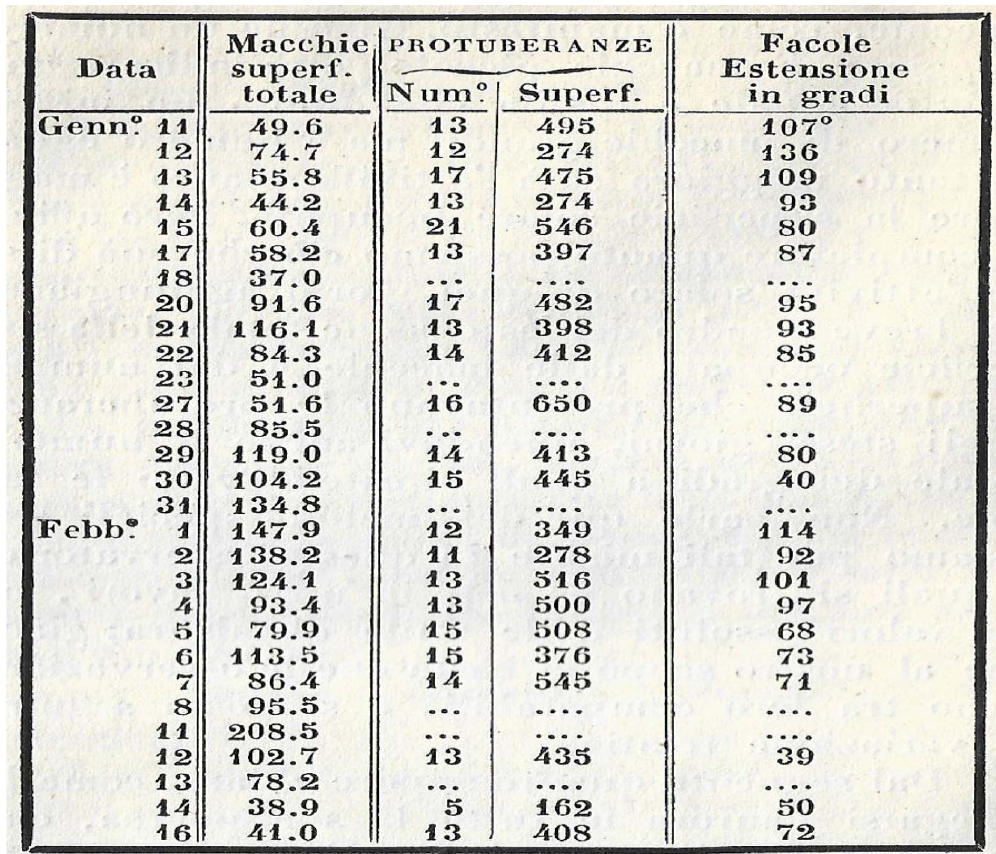
Fig. 5. Table of solar activity observations of January and February 1872 carried out at the Roman College. The different columns record: the date, solar sunspot area (arbitrary units), the number and the extension of prominences, the extension of solar faculae. From the note Studii sull ’ Aurora Elettrica del 4 Febbraio 1872. G. Egidi (Egidi,